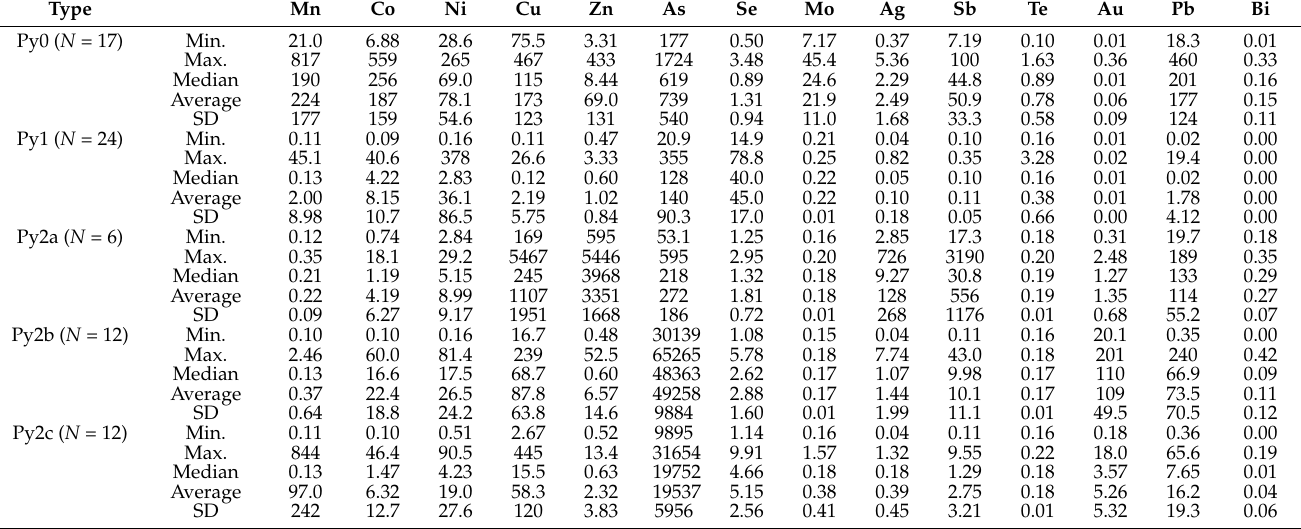
Table 2. The statistical analysis of representative trace elements in pyrites from the Dunbasitao gold deposit determined using LA-ICP-MS